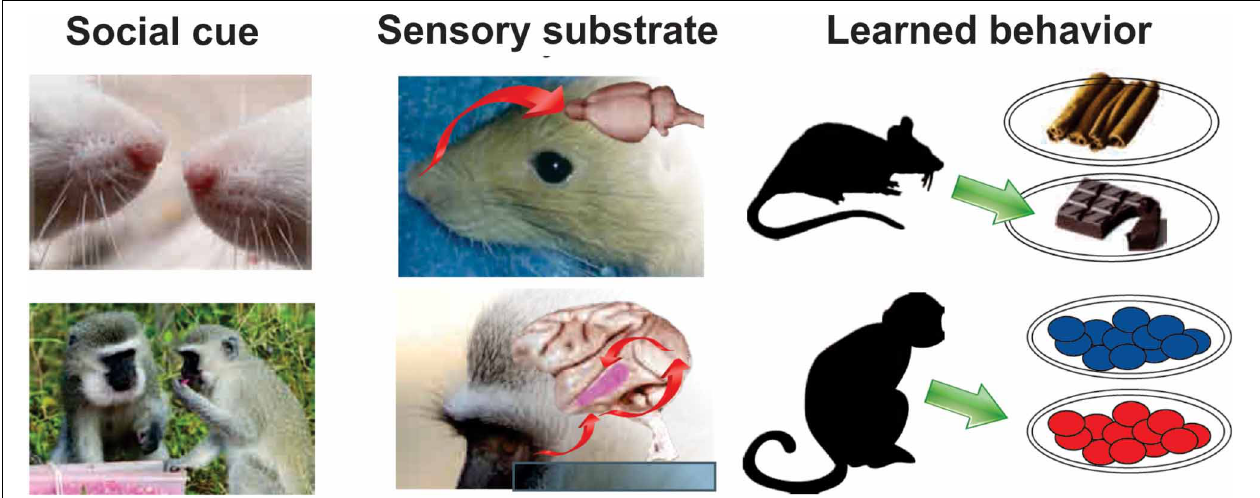
FIGURE 2 | Sensory modalities underlying social learning differ across species. In socially-facilitated food preference, rats (top) rely heavily on olfactory signals. Olfactory trails laid by conspecifics can signal what to eat and where to find it. Moreover, olfactory components from the food detected on the breath of a conspecific, causes rats to prefer the associated food, even when tested weeks later. This preference can also be elicited by pairing the food odorant with carbon disulfide, a volatile chemical found in the breath (reviewed in Galef, 2012). In contrast, primates (bottom) are heavily visual. Visual cues convey information about